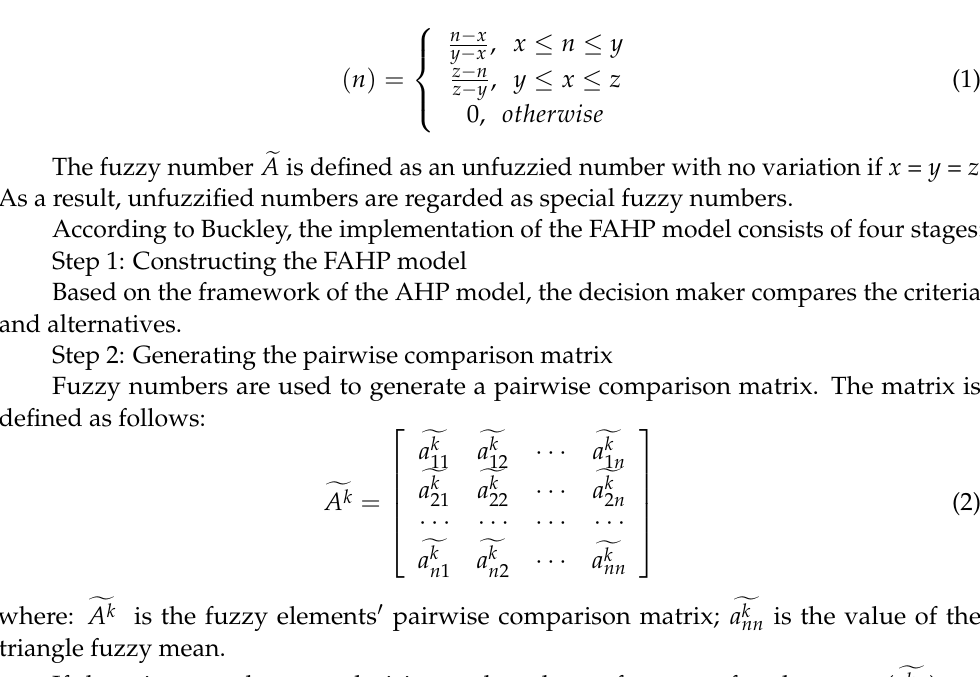
Figure 2. Triangular Fuzzy Number.